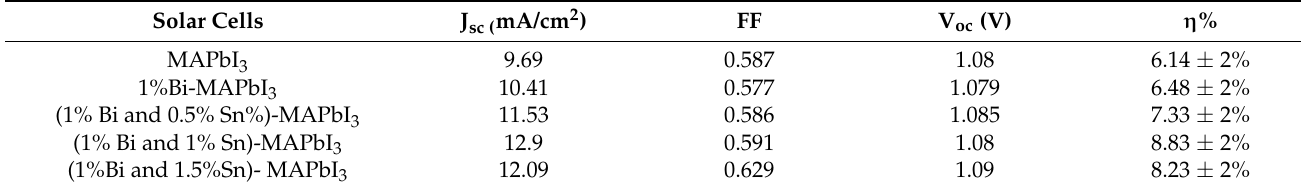
Table 3. Solar cell parameters of pure and Bi–Sn co-doped MAPbI 3